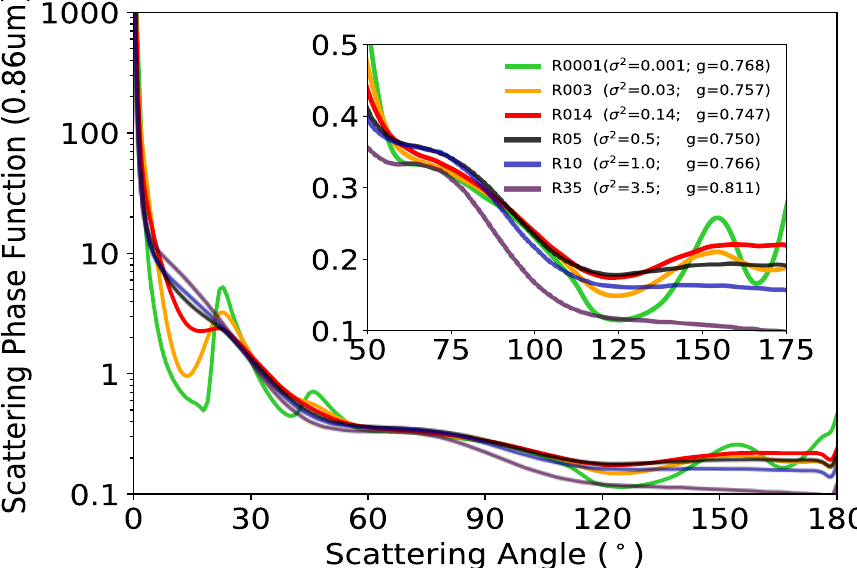
Figure 1. The phase functions of an aggregate of eight randomly attached hexagonal particles with an effective radius of 30 µ m for six different degrees of surface roughness ( σ 2 ): 0.001 (R0001), 0.03 (R003), 0.14 (R014), 0.5 (R05), 1.0 (R10), and 3.5 (R35). The asymmetry factor ( g ) of each ice model is listed in the